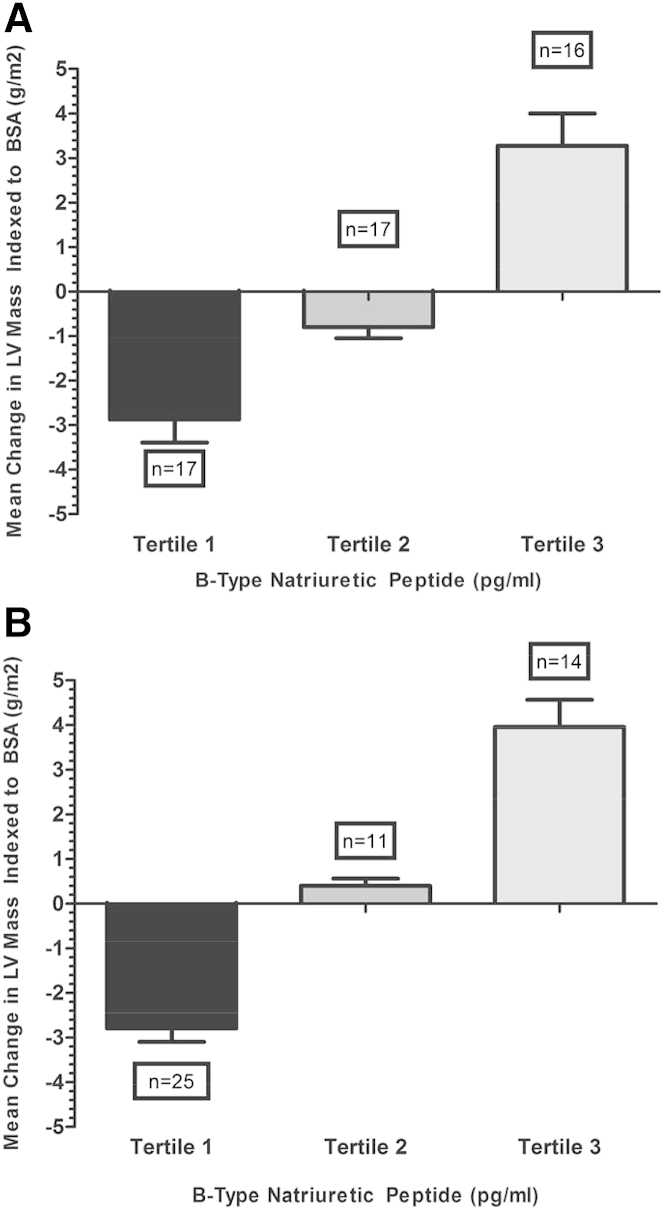
ΔLVM Across the BNP TertilesThe top diagram (A) uses the BNP tertile levels of this n = 50 cohort; the lower diagram (B) uses the BNP tertile levels of the original larger n = 300 cohort (1). Tertiles for n = 50: tertile I 5 to 6.40 pg/ml, tertile II 6.9 to 15.5 pg/ml, tertile III 18.6 to 37.5 pg/ml. BSA = body surface area; LVM = left ventricular (LV) mass.